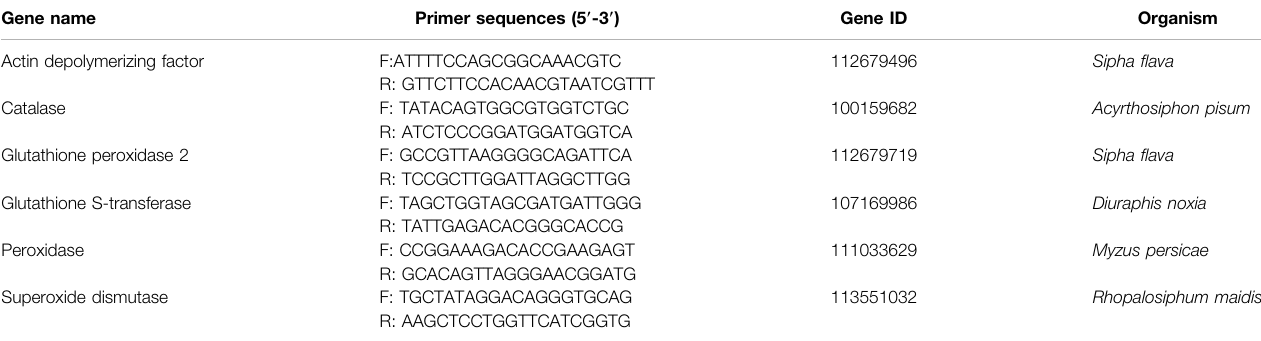
TABLE 1 | Primers used in the qRT-